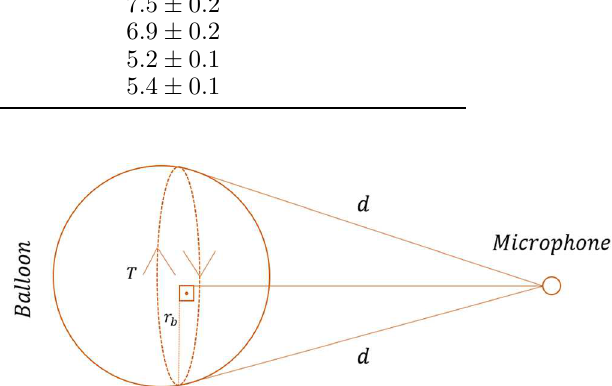
Fig. 3. Diagram considering the experimental condition that the distance d between the plane of rotation of the nut and the microphone. T is the trajectory of the nut and r b is the radius of the